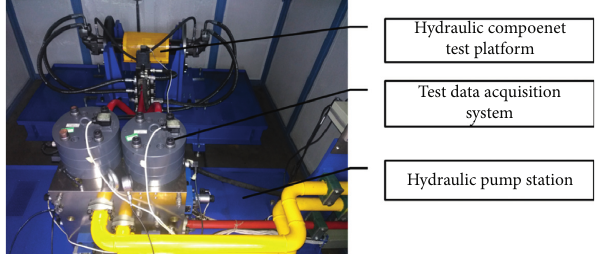
Figure 3: Hydraulic test rig.